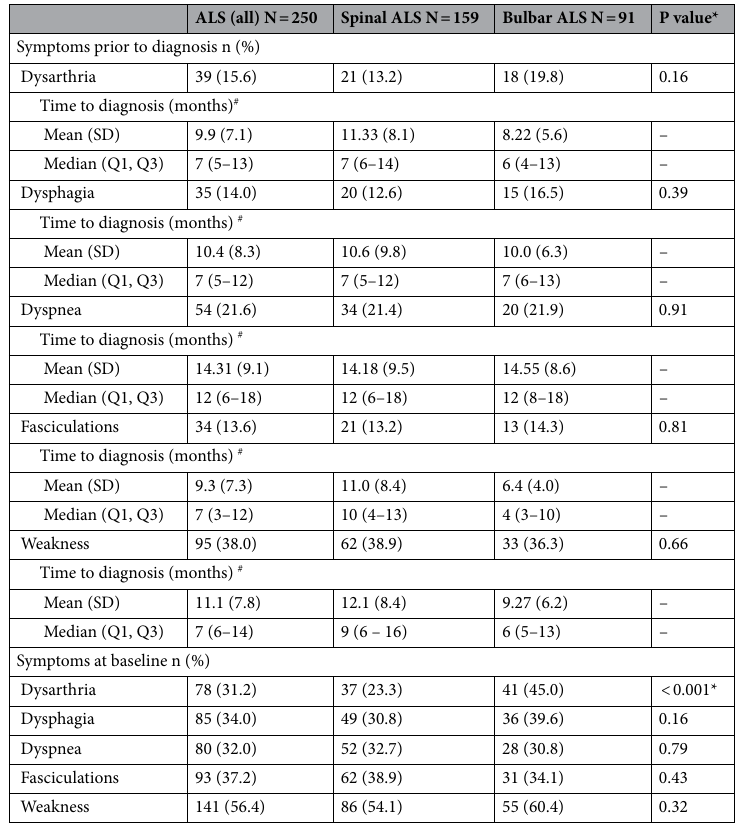
Table 3. Occurrence of symptoms prior to diagnosis and at baseline. Pre-diagnosis analyses were performed using a window of [-3 years, -3 months) around diagnosis date. Baseline analyses were performed using a window of [− 3, + 1 months) around diagnosis date. *Statistically significant differences between spinal and bulbar ALS were calculated using Pearson’s chi-squared tests. **Patients with at least one year of information available prior to ALS diagnosis. # Time passed between first symptom occurrence and ALS